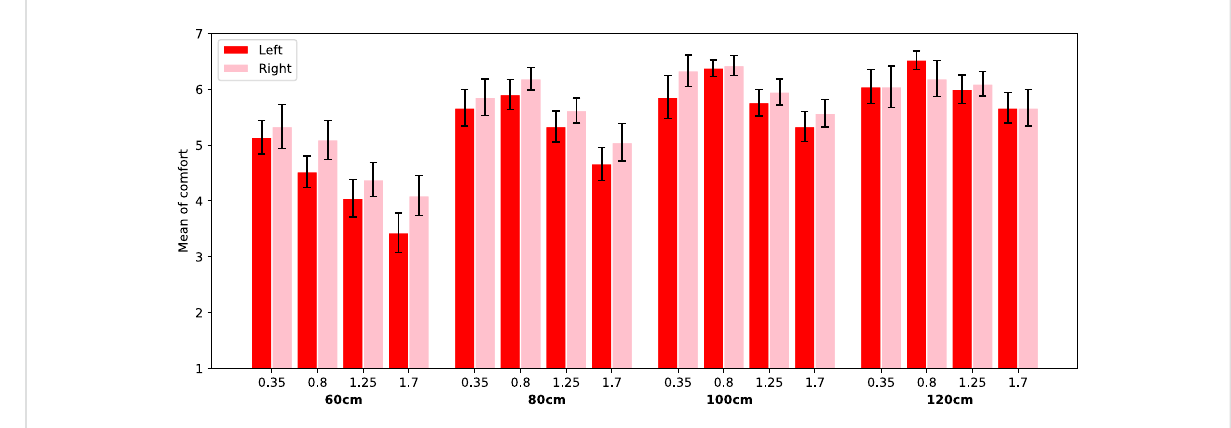
FIGURE 9 Average comfort values for the trials with scenario passing. Error bars represent Standard Error.